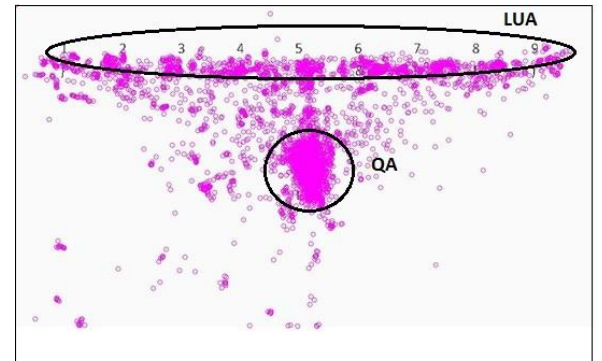
Fig. 3 Sample gaze map on DSST